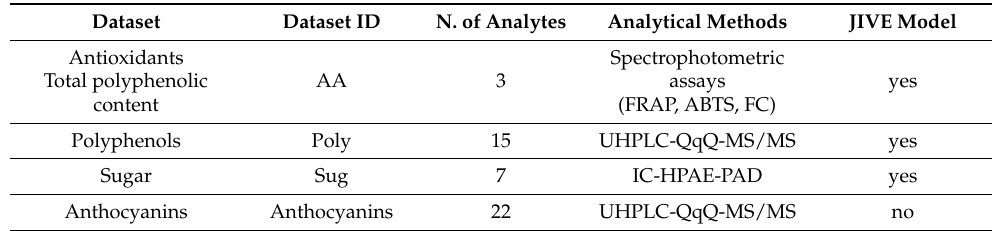
Table 2. List of datasets used for the data fusion approach based on JIVE. Each dataset was identified by a dataset ID and gathered a specific number of analytes. The analytical methods were reported. More detailed information regarding the quantitative data, which composed the datasets, can be found in Table S3 (AA, Poly, Sug) and Table S4 (Anthocyanins). Dataset Dataset ID N. of Analytes Analytical Methods JIVE Model Antioxidants Spectrophotometric Total polyphenolic AA 3 assays yes content (FRAP, ABTS, FC) Polyphenols Poly 15 UHPLC-QqQ-MS/MS yes Sugar Sug 7 IC-HPAE-PAD yes Anthocyanins Anthocyanins 22 UHPLC-QqQ-MS/MS